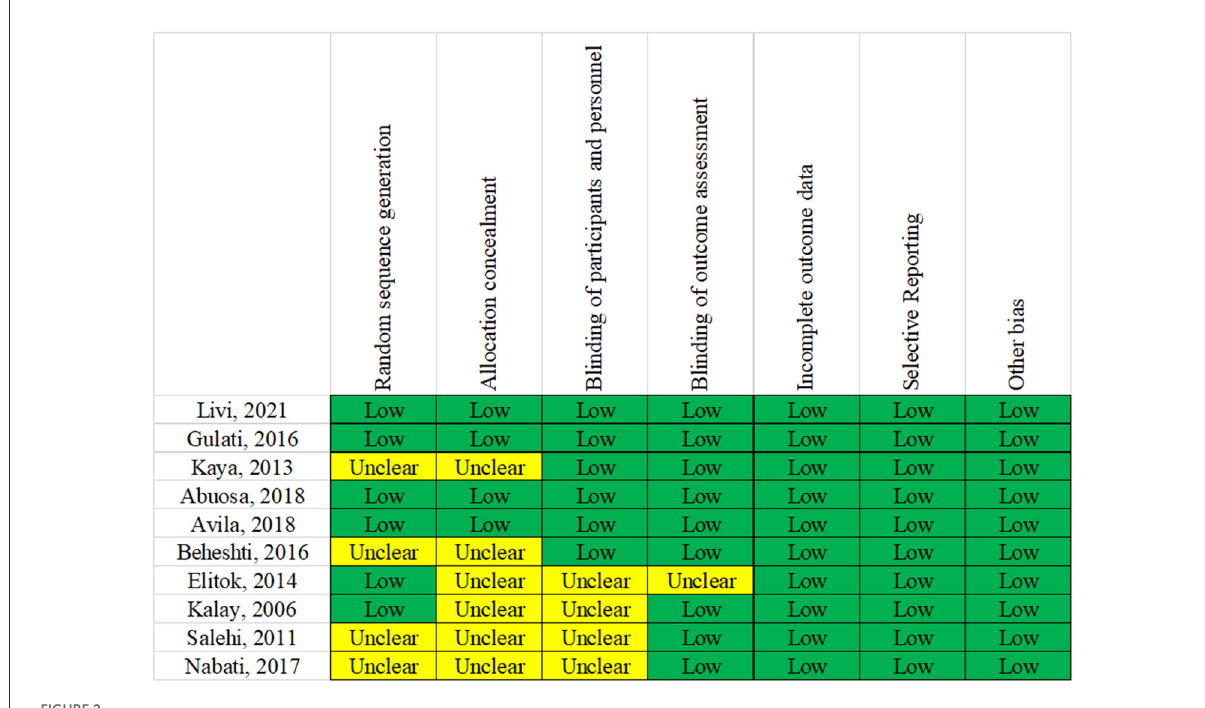
FIGURE2 Risk of bias in the included